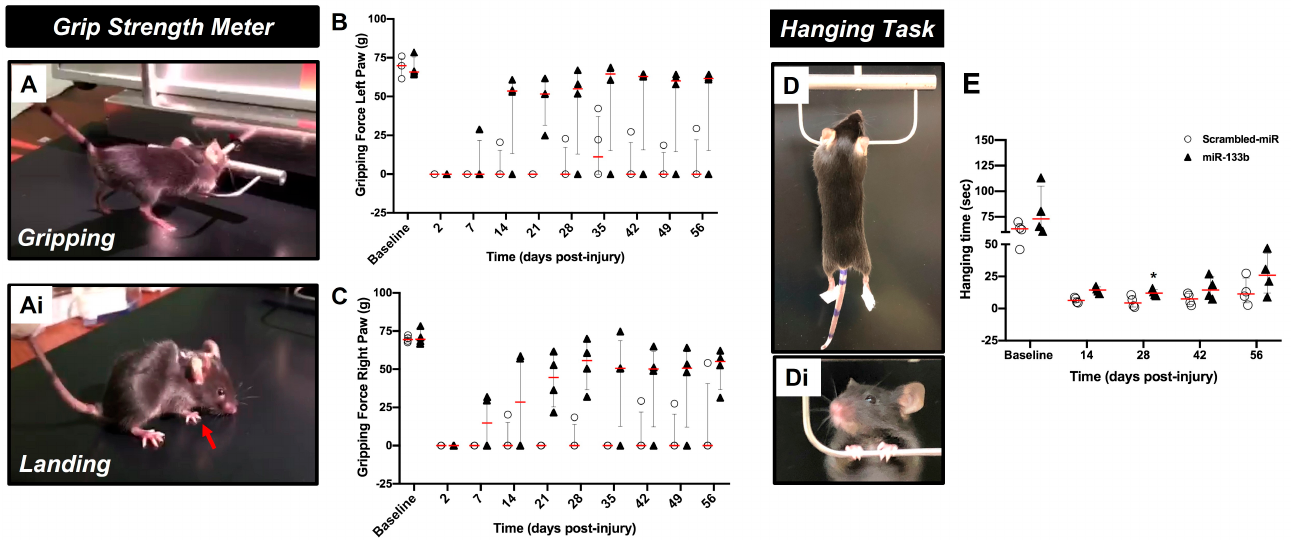
Figure 2. The effect of intranasal delivery of miR133b/Ago2 alone on forelimb gripping and grasping recovery in mice. The graphs represent the forelimb gripping (panels A – C ) and grasping (panel D , E ) assessments during 56 days of recovery, post-injury (DPI) in miR133b/Ago2 and scrambled − miR treated mice. Panels ( A , Ai ) show representative images of the gripping and landing procedures during the GSM testing. Panels ( D , Di ) represent the grasping procedure during hanging task. Two − way Repeated Measures, ANOVA, followed by the Bonferroni’s multiple comparison test. * p < 0.05 when compared miR133b to scrambled − miR group. The circles and triangles in each graph represent the individual mouse performance per group. The red line shows the median with interquartile range. The red arrow indicates the plantar position at landing.